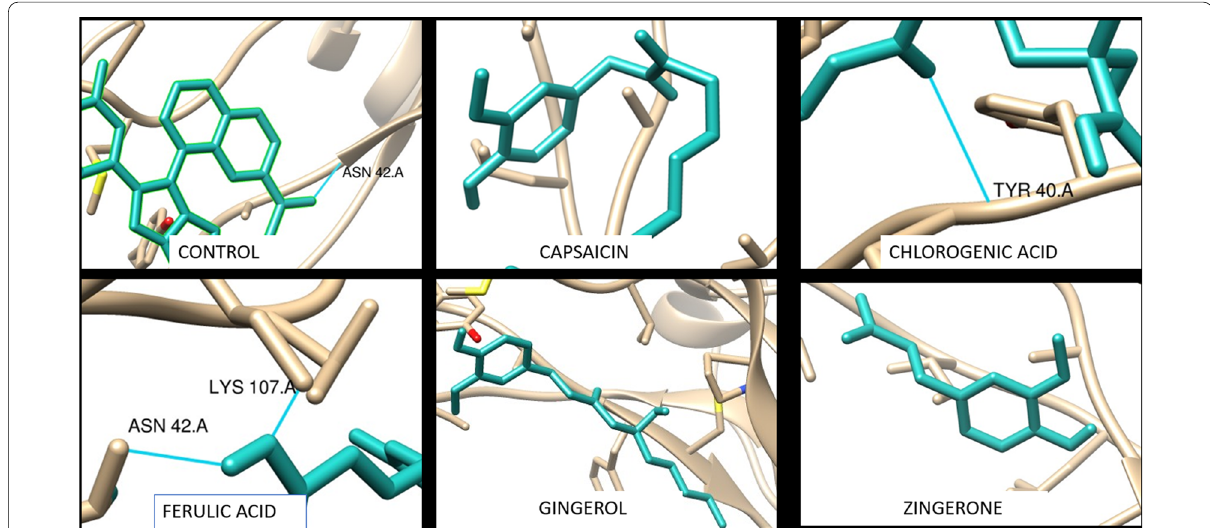
Fig. 4 Docked pictures of curcumin analogues and galunisertib (control) against TGF-β receptor. (Ligand represents the blue sticks, hydrogen bond interaction is represented in blue line, and receptor is represented in solid white ribbon form)